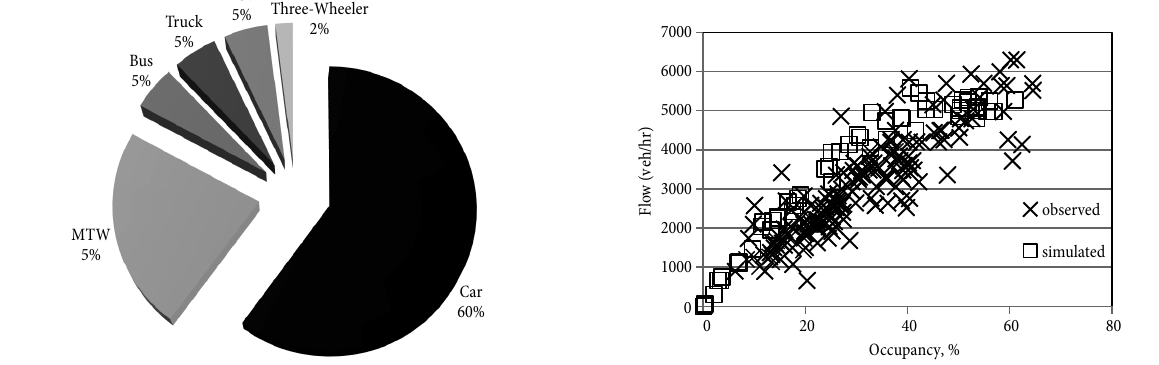
Fig. 4. Traffic composition used for validating VISSIM Fig. 5. Observed and simulated flow-occupancy relationship Table 1. Acceleration deceleration behavior of various types of vehicles used in VISSIM validation Vehicle